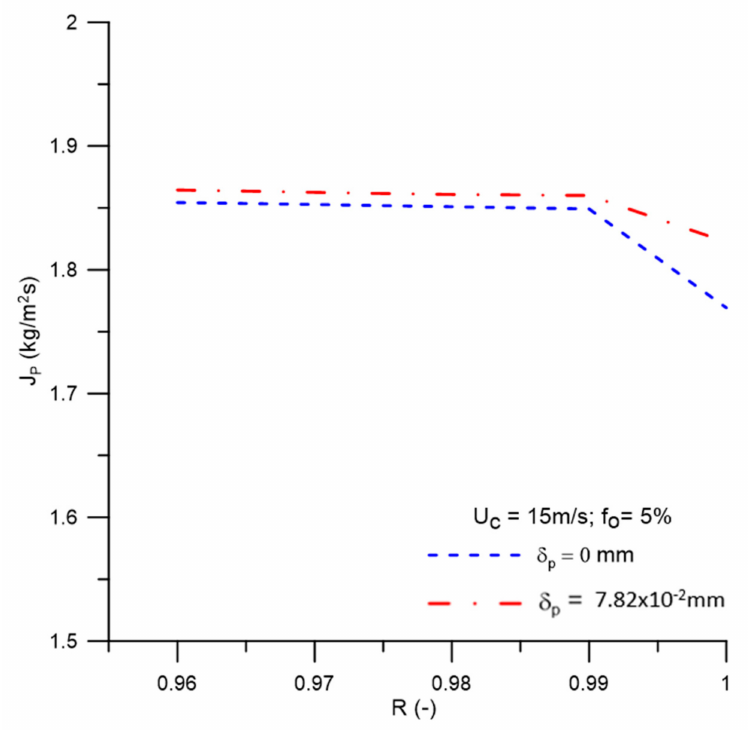
Figure 15. Permeate flow behavior as a function of the membrane rejection coefficient.